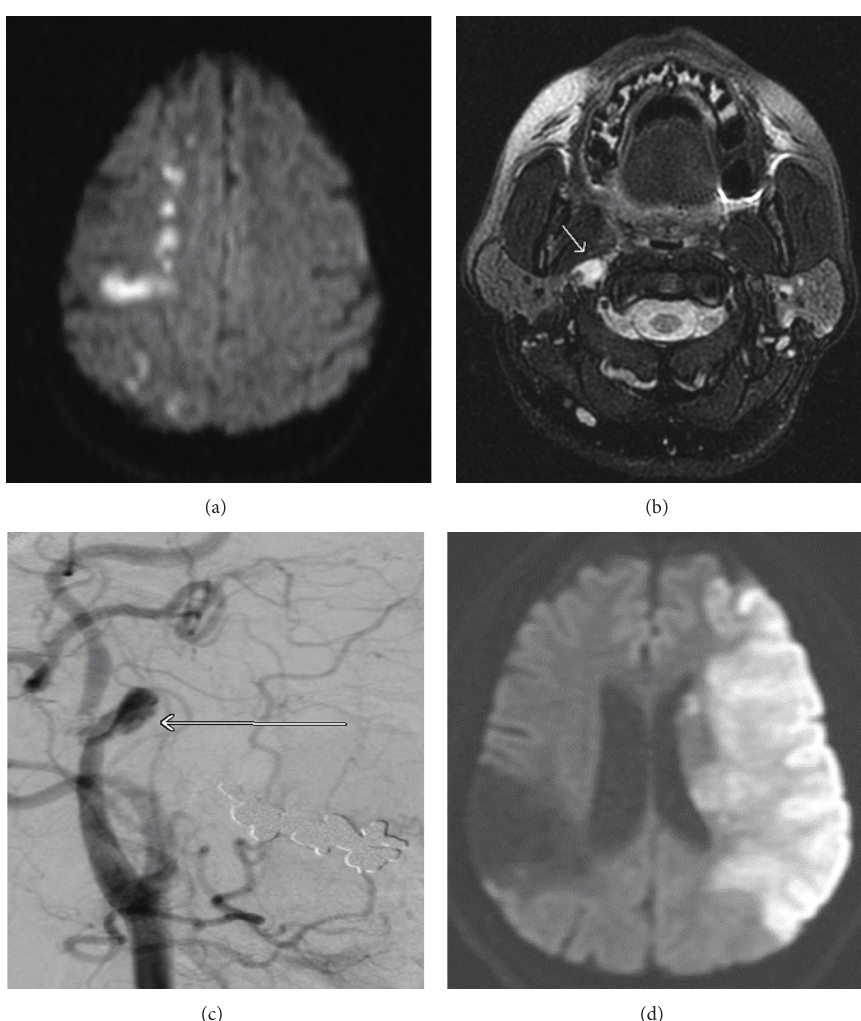
Figure 1: ((a)–(d)) 39-year-old female presenting with acute onset of a right-sided headache associated with left hemiparesthesia and hemiparesis following sexual intercourse. (a) Initial brain MRI axial DWI sequence demonstrates abnormal restricted diffusion in a watershed distribution of the right cerebral hemisphere consistent with an acute stroke. (b) Axial T1-weighted fat-saturated sequence of the neck vessels demonstrates a hyperintense signal abnormality within the subintimal space of the right internal carotid artery (arrow) consistent with a dissection. (c) Conventional angiogram of the right internal carotid artery demonstrates a 360 ∘ loop with an associated fusiform aneurysm filled with thrombus (arrow). (d) Patient presented with acute onset of right hemiplegia and global aphasia 8 years after her first stroke. Brain MRI axial DWI sequence demonstrates a large region of abnormal restricted diffusion in the left cerebral hemisphere consistent with an acute stroke in the left middle cerebral artery distribution. There is encephalomalacia of the right parietal lobe in the region of her prior